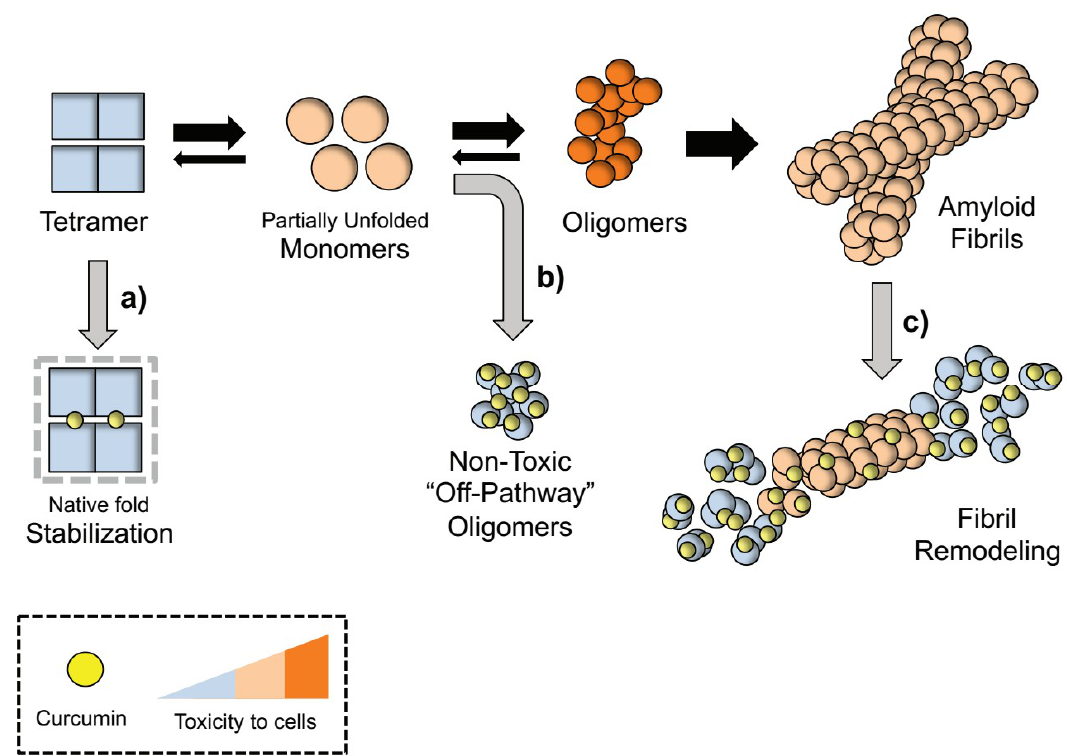
Figure 1. Proposed mechanism for TTR aggregation pathway modulation by curcumin. Rate-limiting tetramer dissociation of TTR into partially unfolded monomers precedes the formation of toxic oligomeric intermediates that evolve into β -sheets enriched mature fibrils. Curcumin modulates TTR cascade by directly interacting with different binding partners: ( a ) Curcumin interaction with TTR at the T 4 binding pockets stabilizes the tetrameric fold and blocks its dissociation into unfolded monomeric species [15,58,68]; ( b ) Curcumin interaction with partially misfolded non-native monomers redirects TTR aggregation into “off-pathway” unstructured oligomers innocuous to cells [58,68]; ( c ) Curcumin breaks down and remodels β -sheet rich TTR fibrils in smaller amorphous aggregates in in vitro [58] and in vivo [70].